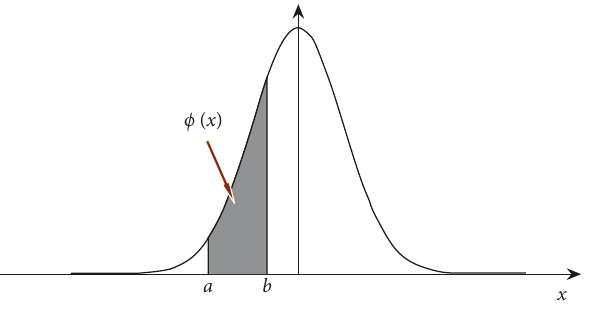
Figure 2: The probability of Gaussian